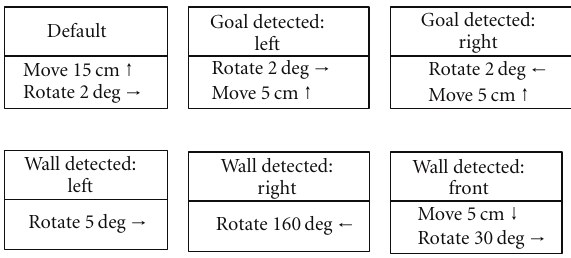
Figure 8: A simple program for the maze explorer.